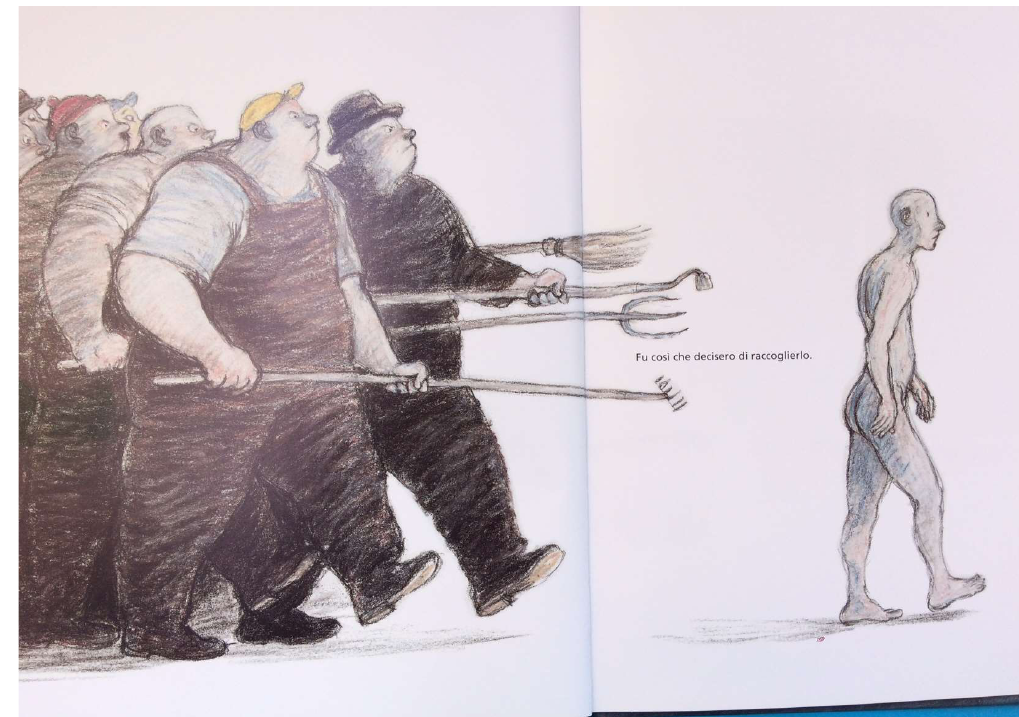
Figure 4. The inhabitants of the island hunt the refugee, by: L’Isola , cit. pp.